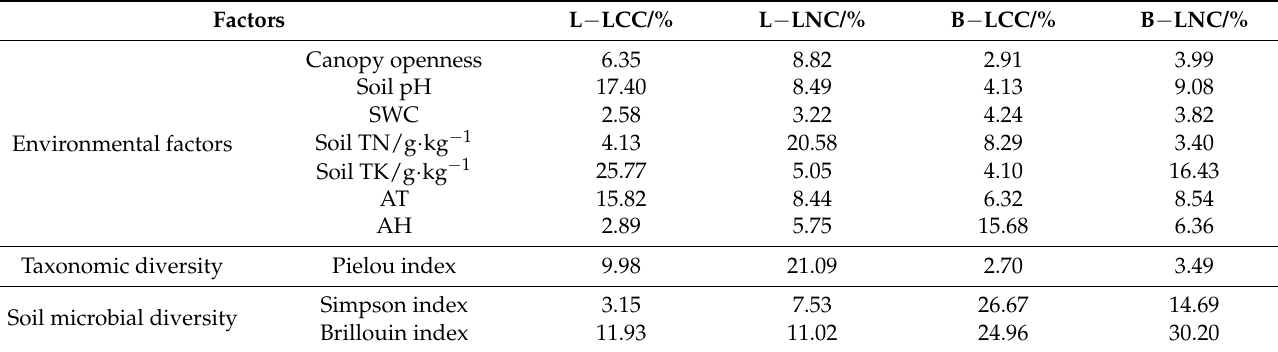
Table A8. The explanatory variables for factors in litter nutrient release at the late decomposition